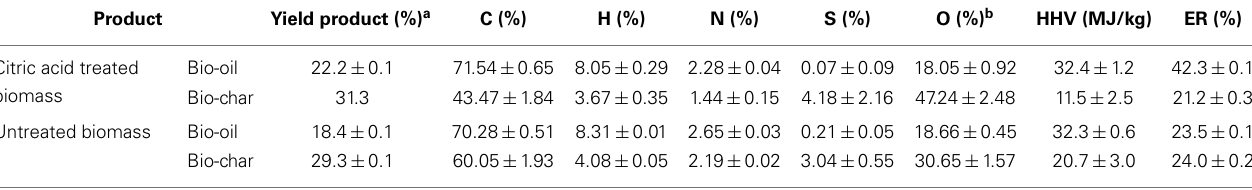
Table 3 | Ultimate analysis, product yield and energy recovery of HTL bio-crude and bio-char product obtained from untreated and demineralized Sargassum